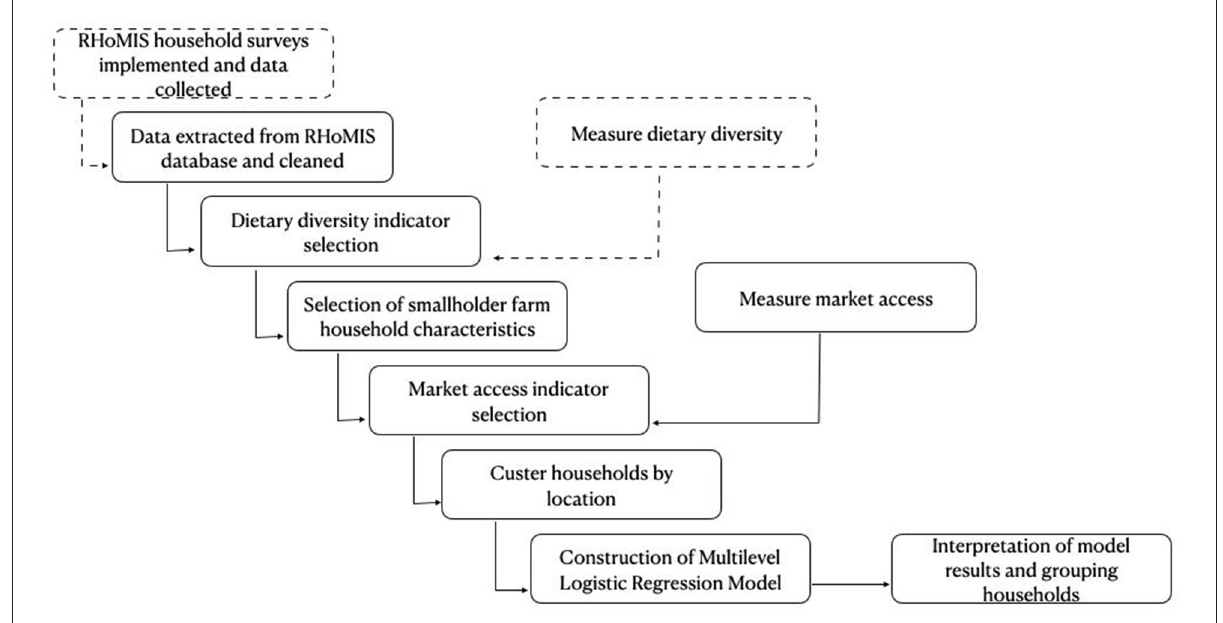
FIGURE1 Flow diagram denoting each stage of the methodology. Dashed lines indicates process or decision outside the control of the